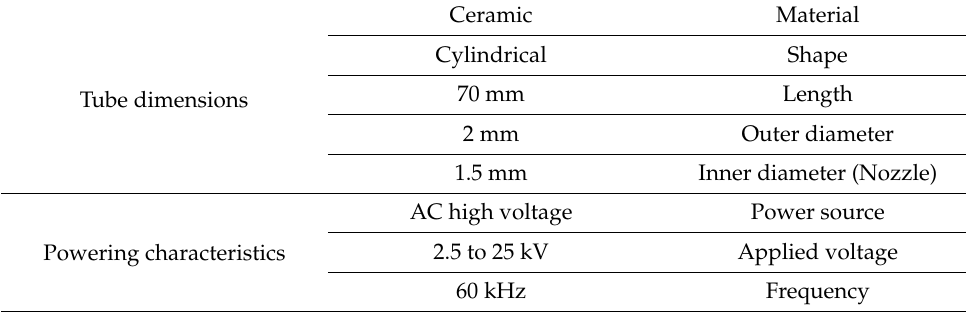
Table 2. Equivalent O 2 flow rate